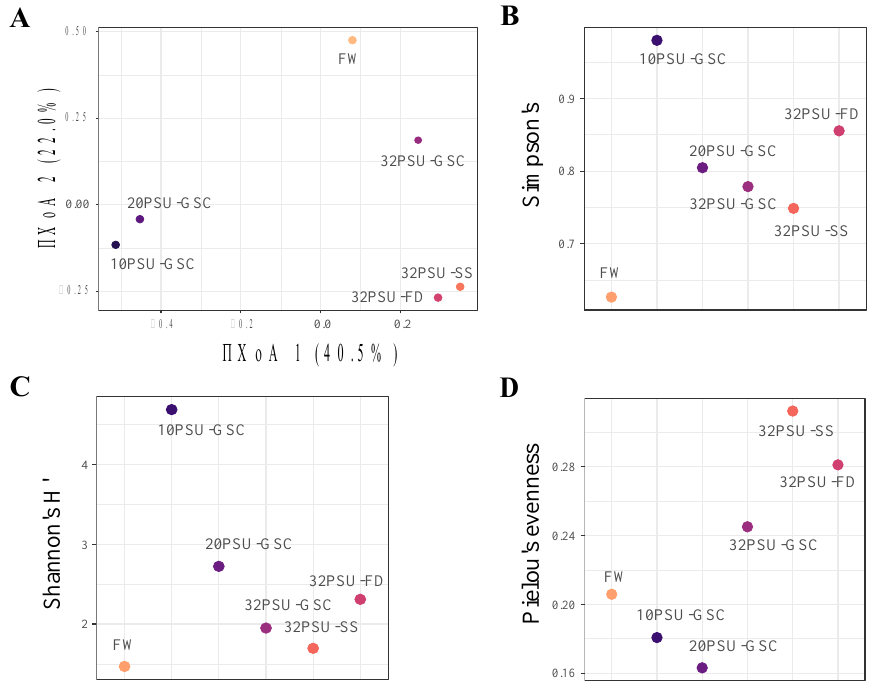
Figure 1. Diversity index of Atlantic Salmon intestinal microbiota between salinity treatments. FW: Fresh water previous treatment group, GSC: gradual salinity change at 10 PSU, 20 PSU, and 32 PSU groups; 32PSU-SS Salinity shock at 32-PSU group; 32PSU-FD: Salinity shock at 32 PSU group previously feeding with a functional diet. ( A ) PCoA plot of the beta diversity of microbiomes calculated by Bray-Curtis dissimilarity; ( B ) The Simpson’s 1-D; ( C ) Shannon diversity index; and ( D ) Pielou’s evenness.